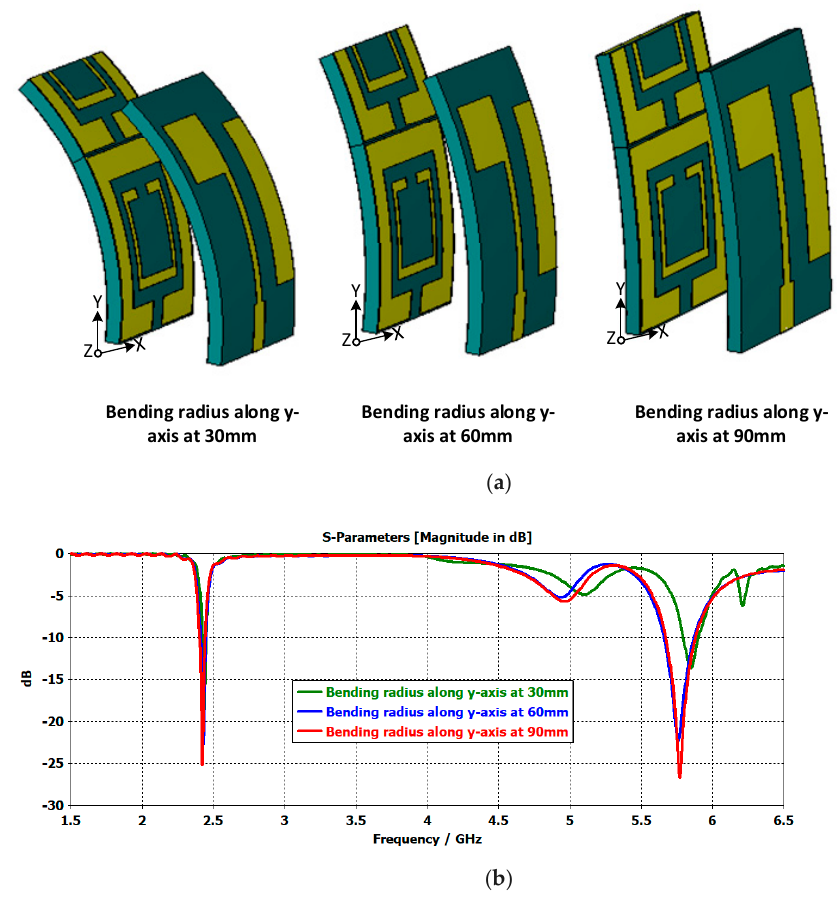
Figure 19. ( a ) Bending analysis of the AMC-backed antenna along the y-axis; ( b ) S 11 behavior at By = 30, 60, and 90 mm.